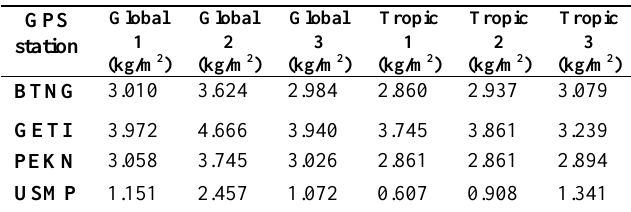
Table 7: Statistical analysis of GPS station using available T M model from Table